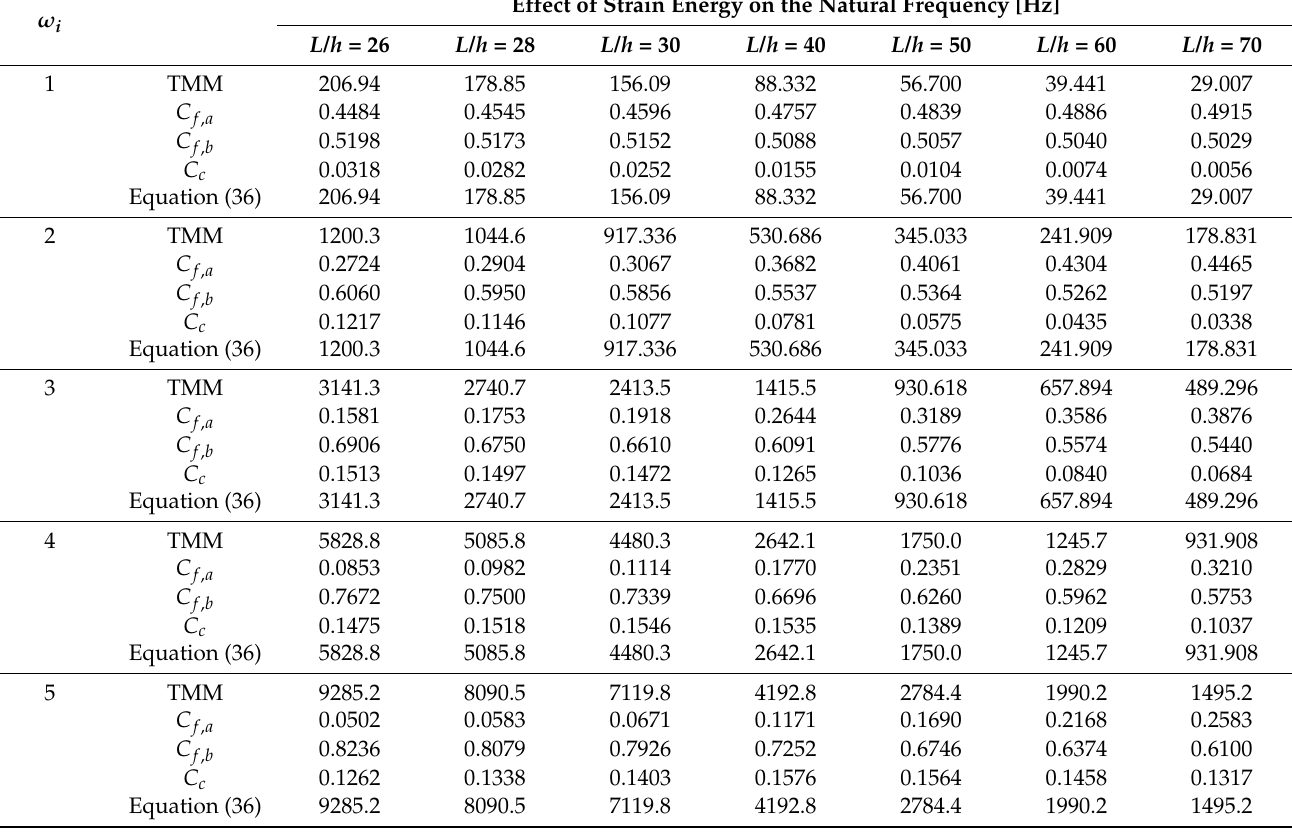
Table 7. Effect of strain energies on the natural frequencies of three-layered beams with the C-P end condition depending on the variation in